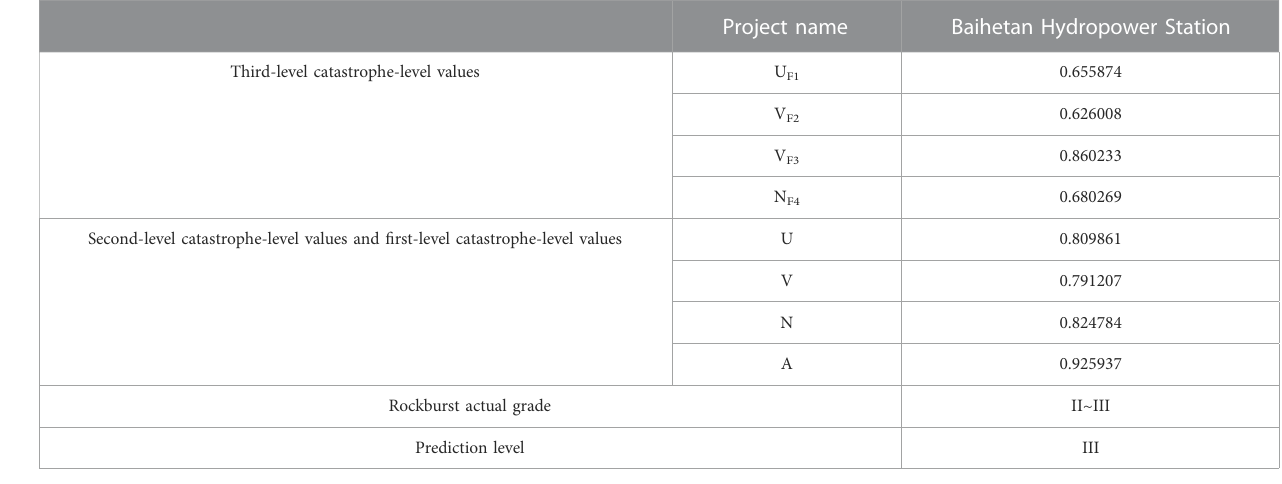
TABLE 10 Rockburst level prediction.